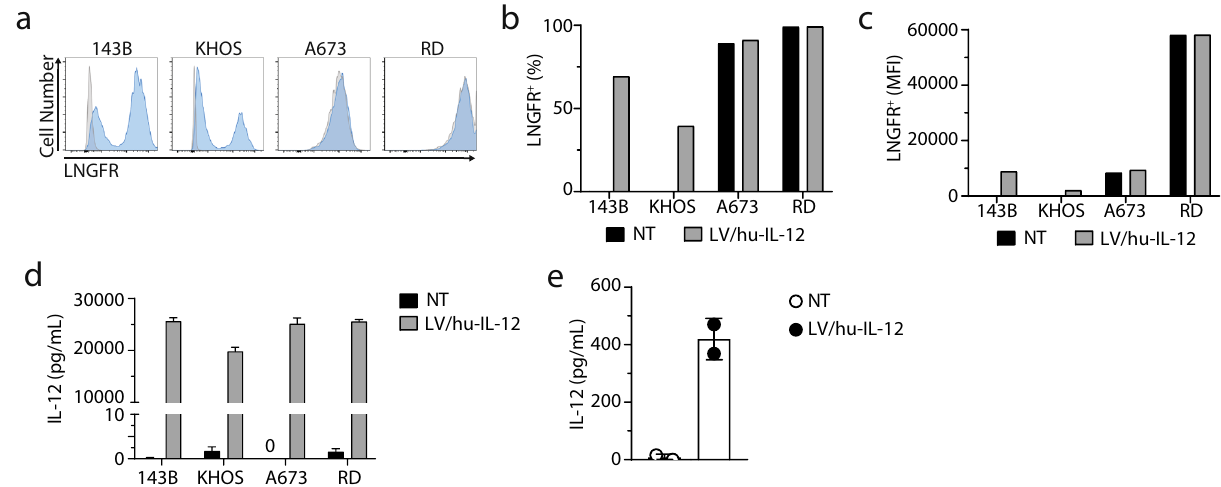
Figure 1. Human sarcoma lines for osteosarcoma (143B and KHOS-240S), Ewing sarcoma (A673), and rhabdomyosarcoma (RD) were transduced with LV/hu-IL-12 containing ΔLNGFR for surface tracking and cell-fate control. ( a ) LNGFR on the surface of the cell was measured by FCM > 72 h after transduction. ( b , c ) Surface LNGFR expression was quantified by percent positivity and mean fluorescent intensity (MFI). ( d ) The IL-12 concentration in the supernatant of transduced or non-transduced cells after 4-h incubation, measured by ELISA. Data represents 3 replicates measured in triplicate, displayed mean ± standard deviation. ( e ) Primary human sarcoma patient sample transduced with LV/hu-IL-12. Supernatant was collected 18 h after media change, and an IL-12 ELISA was performed. Individual transductions are displayed with mean ± standard